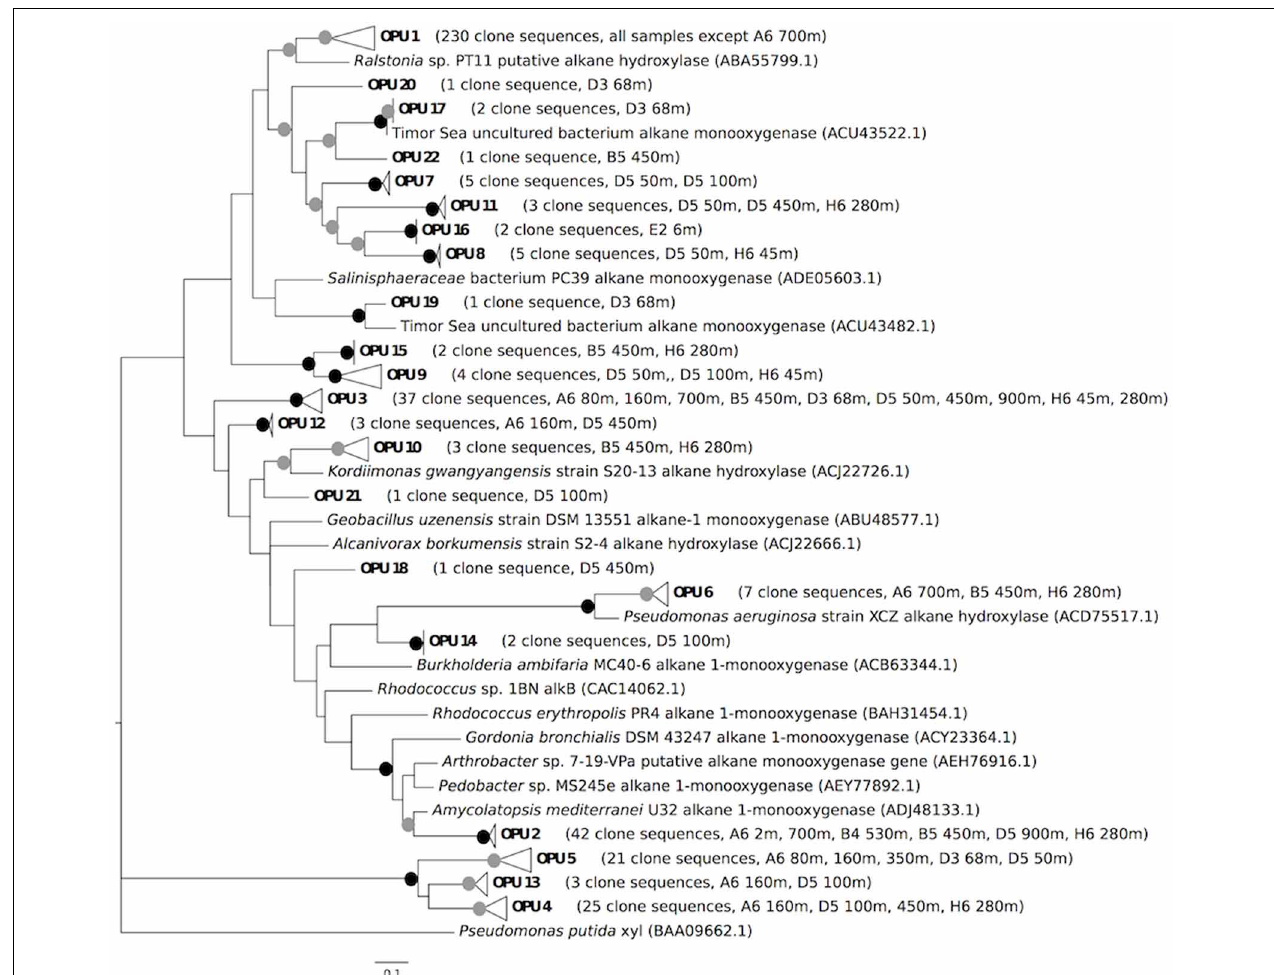
FIGURE 1 | Maximum likelihood tree comparing putative alkB amino acid sequences from this study with reference alkB sequences obtained from other studies. Bootstrap values from 100 resamplings are indicated with black circles for values of 95–100% and gray circles for values of 50–94%. OPUs were determined using a distance cutoff of 0.20 (80% sequence similarity). OPU 1 clusters with the following reference